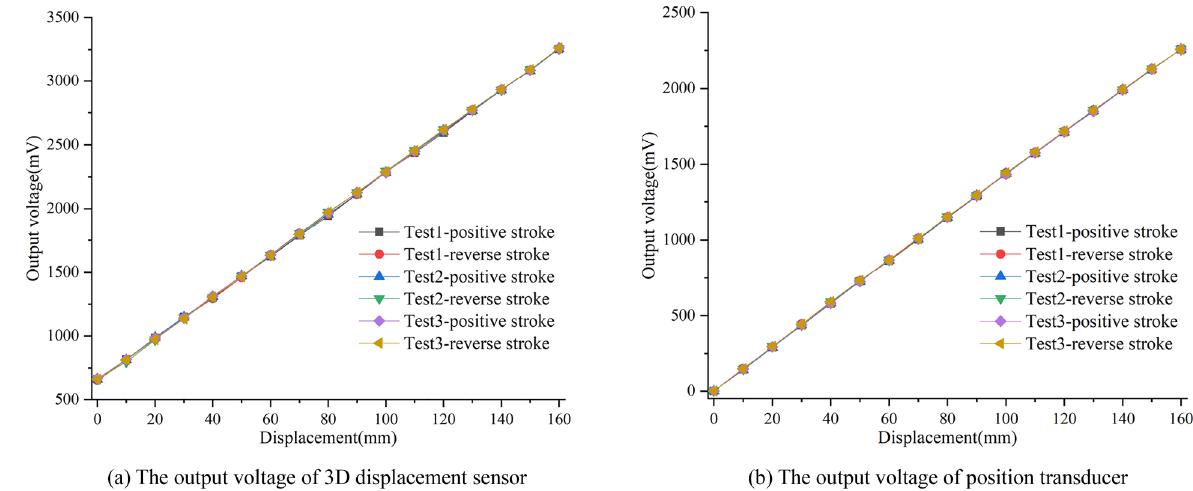
Figure 16. Time history diagram of 3 displacement tests (( a , b ) were generated by Origin 2016 × 64 (https:// www. origi nlab. com/ 2016)).